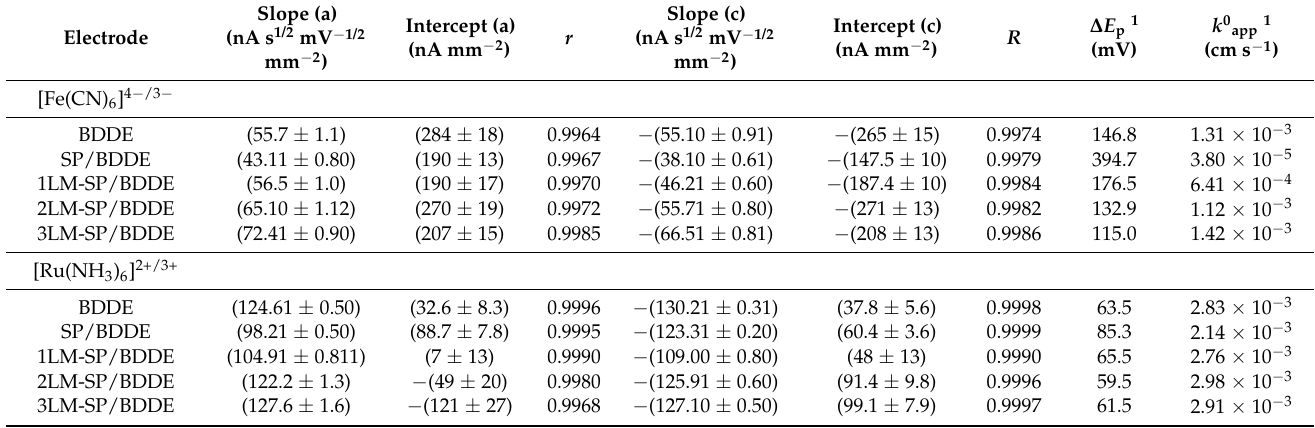
Table 4. Statistical parameters of dependences of current densities on square root of scan rate and ap- parent heterogeneous electron-transfer rate constant ( k 0 app ) for [Fe(CN) 6 ] 4 − /3 − and [Ru(NH 3 ) 6 ] 2+/3+